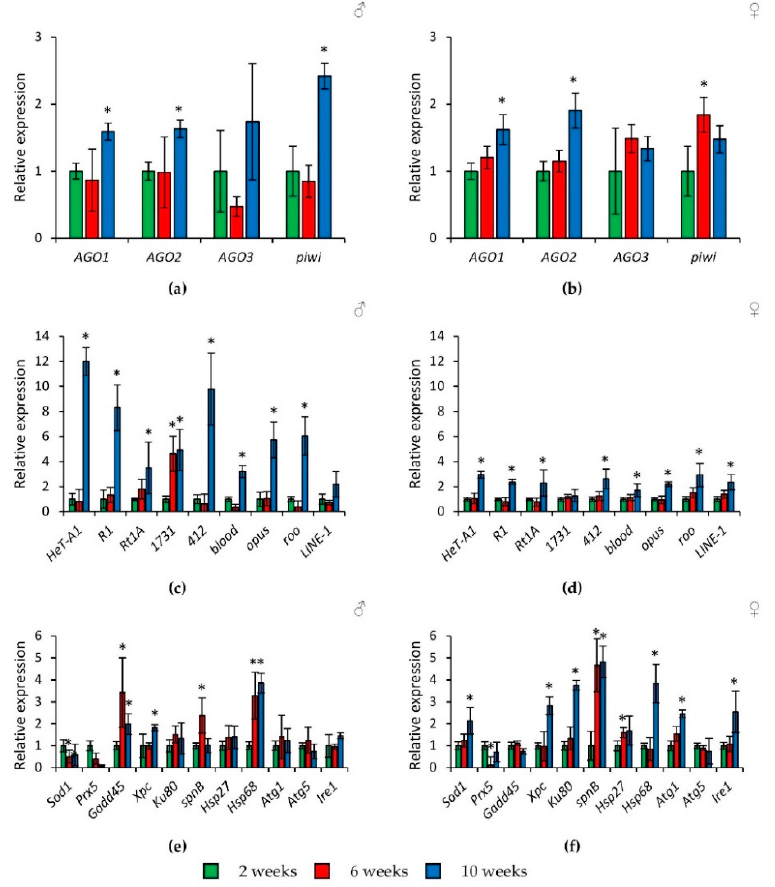
Figure 4. Age-related changes in the expression of Argonaute genes ( a , b ), transposable elements ( c , d ), and stress response genes ( e , f ) in wild-type Canton-S males ( a , c , e ) and females ( b , d , f ). Differences between relative expression levels of the investigated genes at the age of 2 weeks and at the ages of 6 and 10 weeks are statistically significant with * p < 0.05 (Mann-Whitney U-test).